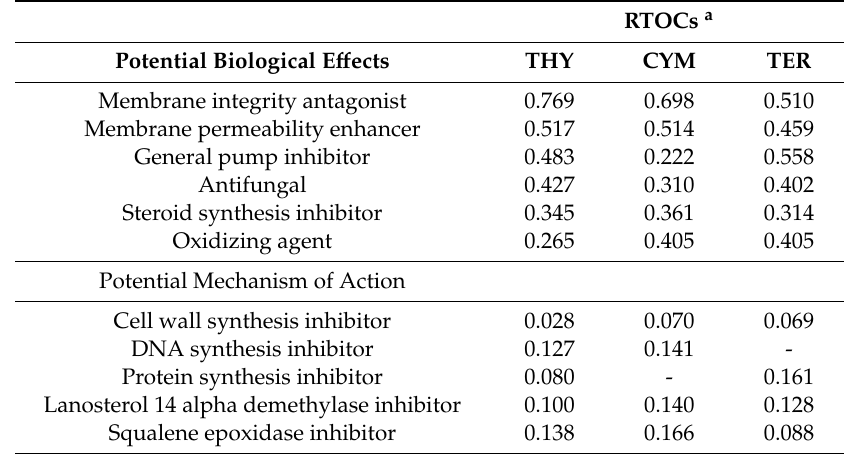
Table 1. In silico test prediction of potential biological e ff ects and potential mechanism of action of RTOCs using the Prediction of Activity Spectra for Substances (PASS) online tool.